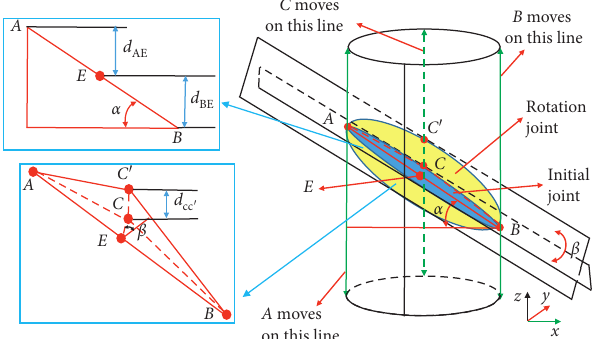
Figure 1: Joint setting of the rock specimen